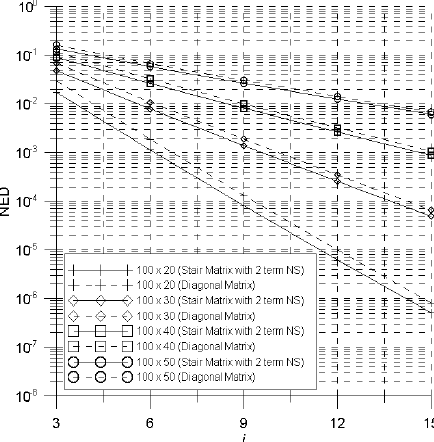
Figure 4. The normalized Euclidean distance (NEDs) with respect to the number of iterations when the initial solutions are s